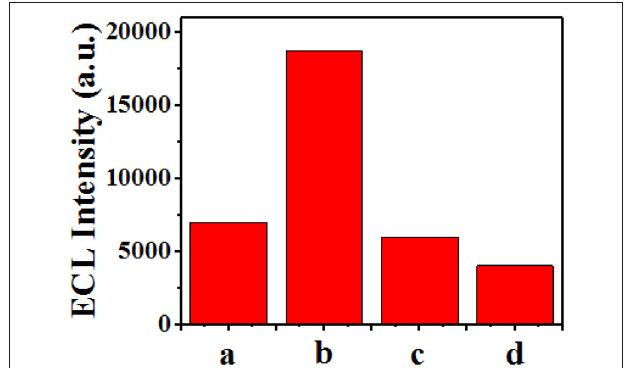
FIGURE 10 | Demonstration of the selectivity of the ECL sensor. Response of the sensor when different substances were added: (a) none, (b) sunset yellow, (c) amaranth, and (d) sodium